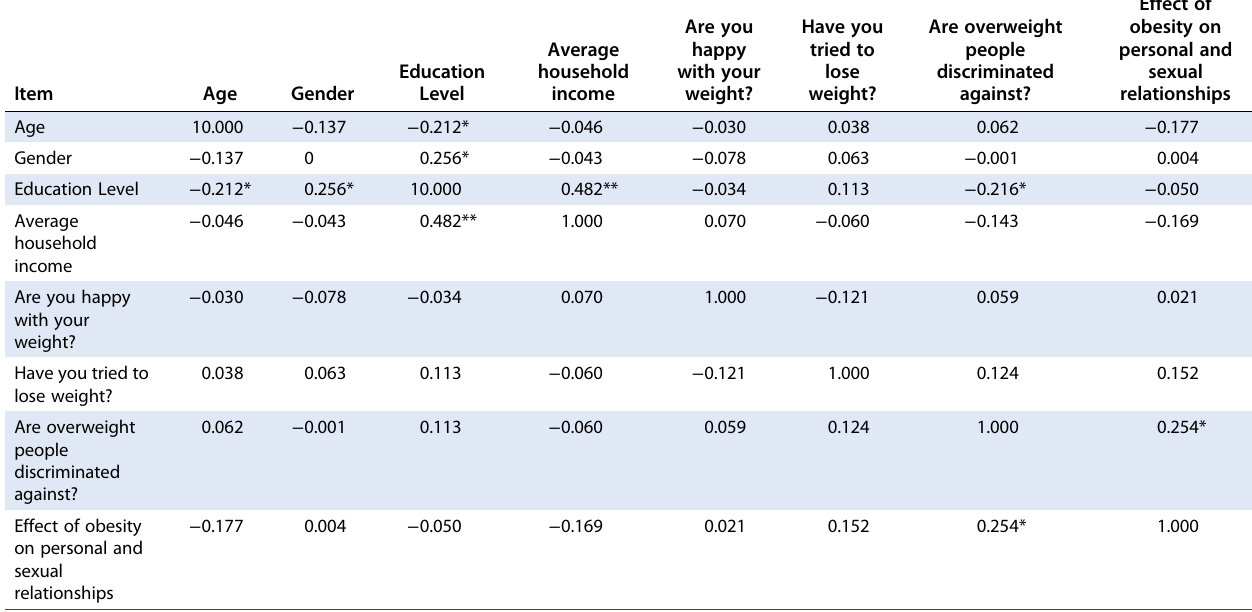
Table 3: Correlations between sociodemographic factors and constructs of weight bias